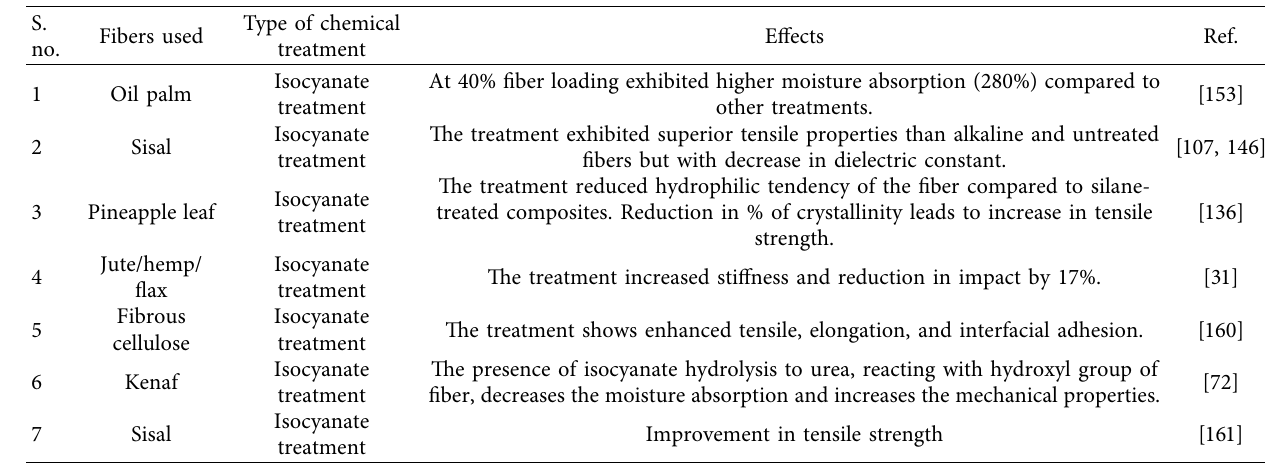
Table 9: Effect of isocyanate treatment on various biofibers.